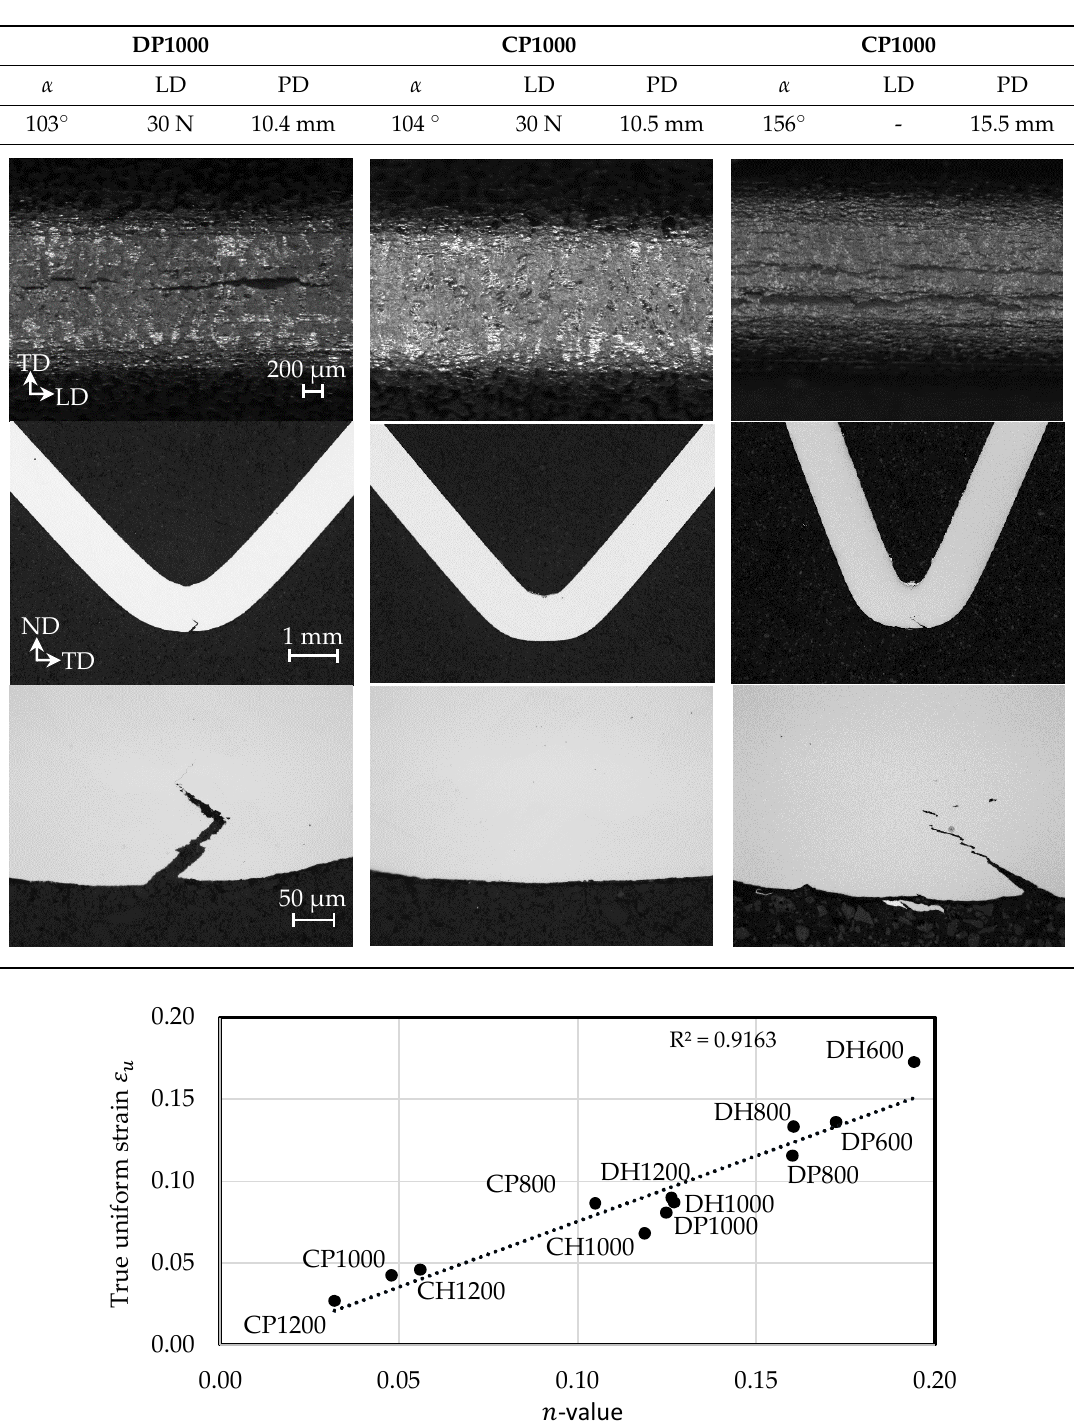
Figure A6. Global formability: Correlation between true uniform strain and n-value.